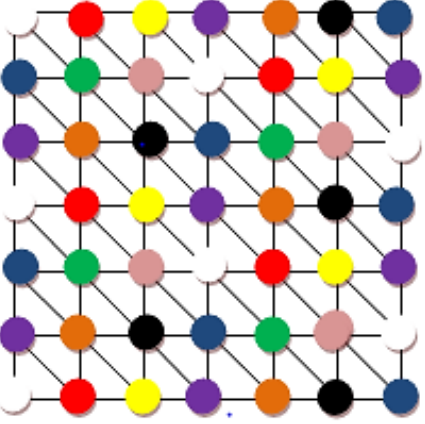
Figure 3. A 7 × 7 cellular graph network matrix colored with the L(2,1) coloring.